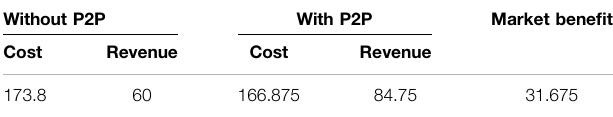
TABLE 4 | Comparison of total cost and